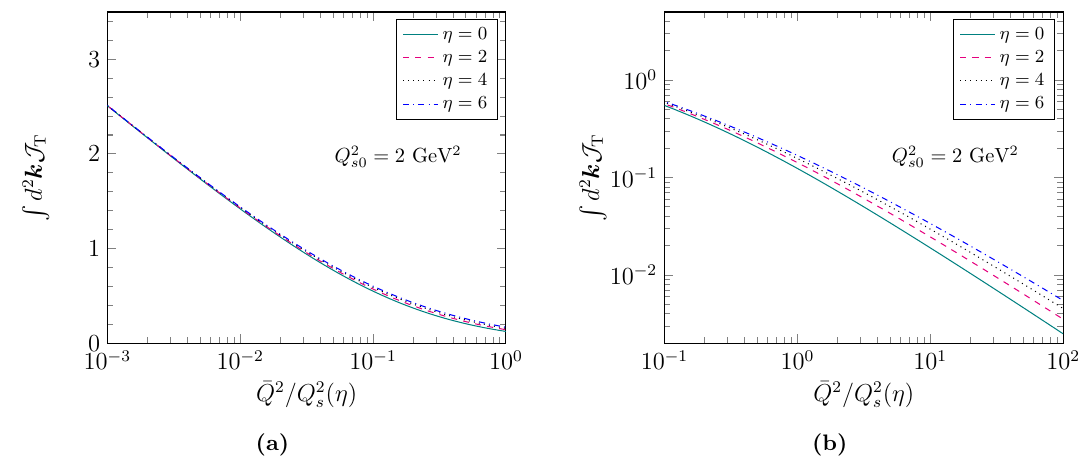
Figure 10. Testing geometric scaling for the SIDIS transverse cross-section integrated over k , from solutions to the collinearly improved rcBK up to η = 6 . (a) Low ¯ Q 2 : the scaling is quasi-perfect. (b) High ¯ Q 2 : with increasing η , the power law tail softens and the scaling becomes more accurate. rapidity η = 6 . In the low virtuality regime at ¯ Q 2 (cid:28) Q 2 ( η ) , one finds a quasi-perfect s scaling (see figure 10a), in agreement with the leading-order estimate in eq. (4.6). At higher virtualities, ¯ Q 2 & Q 2 ( η ) , the scaling becomes better with increasing rapidity s